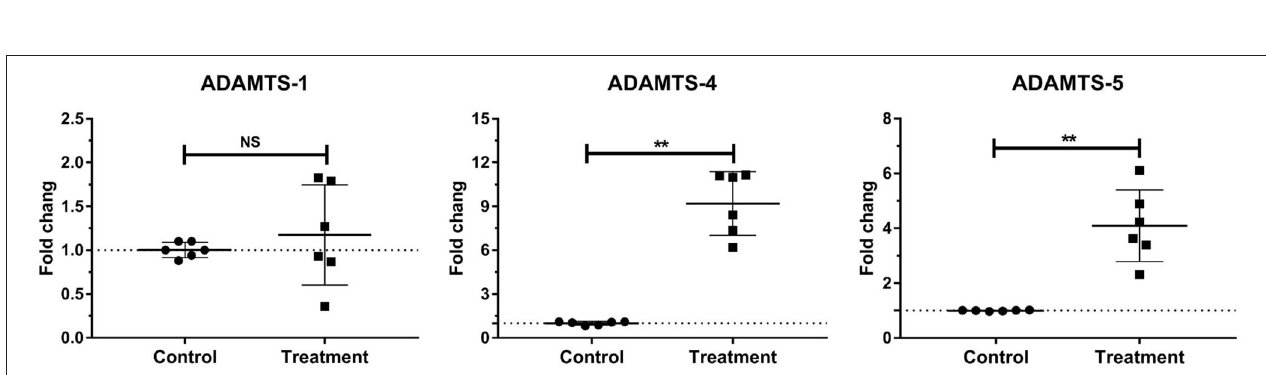
FIGURE 3 | Mean fold changes in ADAM-10 and ADAM-17 mRNA expression following oligofructose-overload administration in dairy heifers. No significant differences in the treatment group relative to those in the control group are indicated as NS.